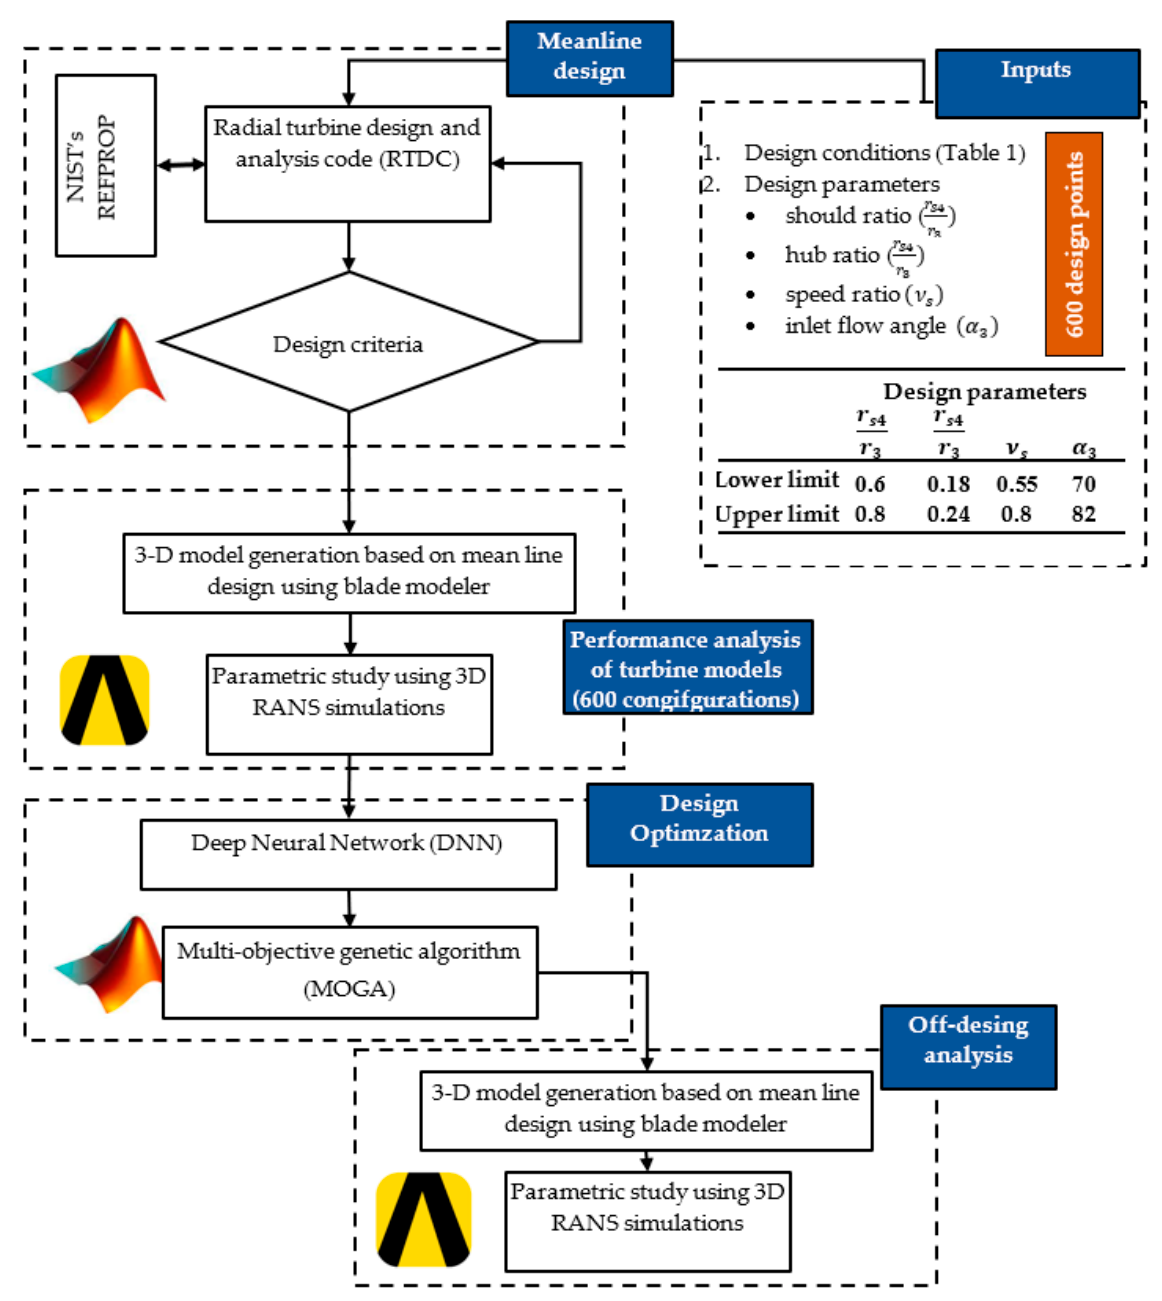
Figure 1. A flow chart of the methodology followed in the current study.